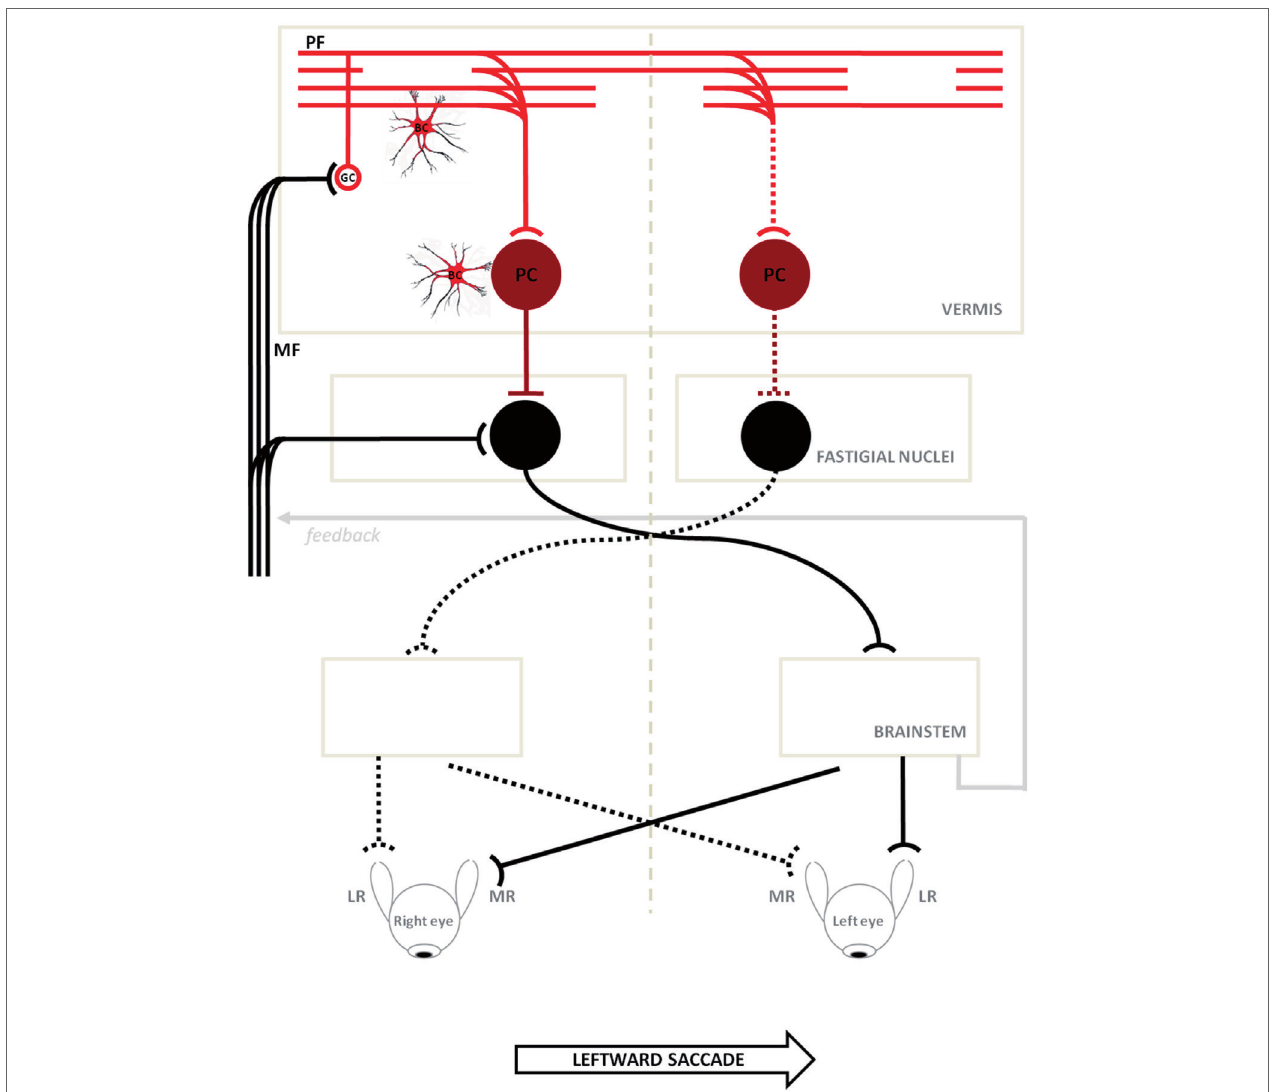
FigUre 6 | Schematic circuitry for generating horizontal saccades (major active pathways are shown) is hypothesized to explain the disorder of our patients. Projections with curved endings are excitatory, while projections with flat endings are inhibitory. Bilateral input to the cerebellar cortical vermis goes from granule cells (GCs) to the caudal fastigial neurons through parallel fibers (PFs) and Purkinje cells (PC). The PC inhibit the fastigial neurons, canceling out the excitatory drive from the mossy fibers. Just before a horizontal saccade is triggered, neurons in the caudal fastigial nucleus (cFN) of the contralateral side with respect to the direction of the movement, discharge a burst of activity driving the excitatory burst neurons in the brainstem, which in turn drive the eyes in a contraversive saccade (continuous line circuit); later, just before a saccade is stopped, neurons in the opposite cFN burst, in order to decelerate and stop eyes exactly on target (broken line circuit). In ataxia-telangiectasia-like disorder, we consider a double pathogenetic effect that may explain its peculiar saccadic behavior: (1) a developmental anomaly principally affecting Bergmann cells associated with a reduction of the expansion of the GC–PF (light red circuit); (2) a neurodegenerative processes further affecting this circuit including PC synapses (dark red circuit). Slowing of parallel fibers conduction may delay the caudal fastigial neurons burst that blocks saccades, making them hypermetric. The damage of the GC–PF–PC synapses also reduces the inhibitory inputs to both caudal fastigial neurons causing abnormally fast contralateral saccades. The model is adapted from Optican and Quaia (31). ML, media recti; LR, lateral